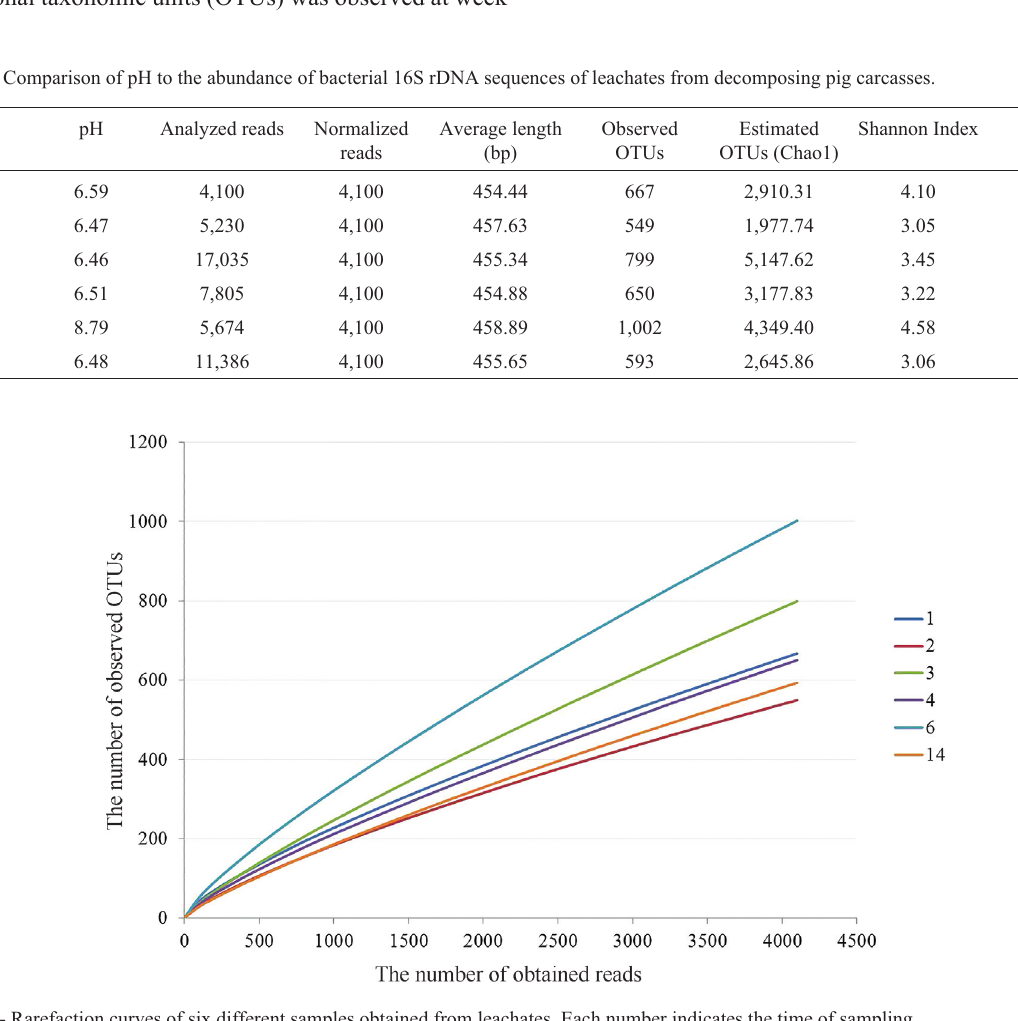
Figure 1 - Rarefaction curves of six different samples obtained from leachates. Each number indicates the time of